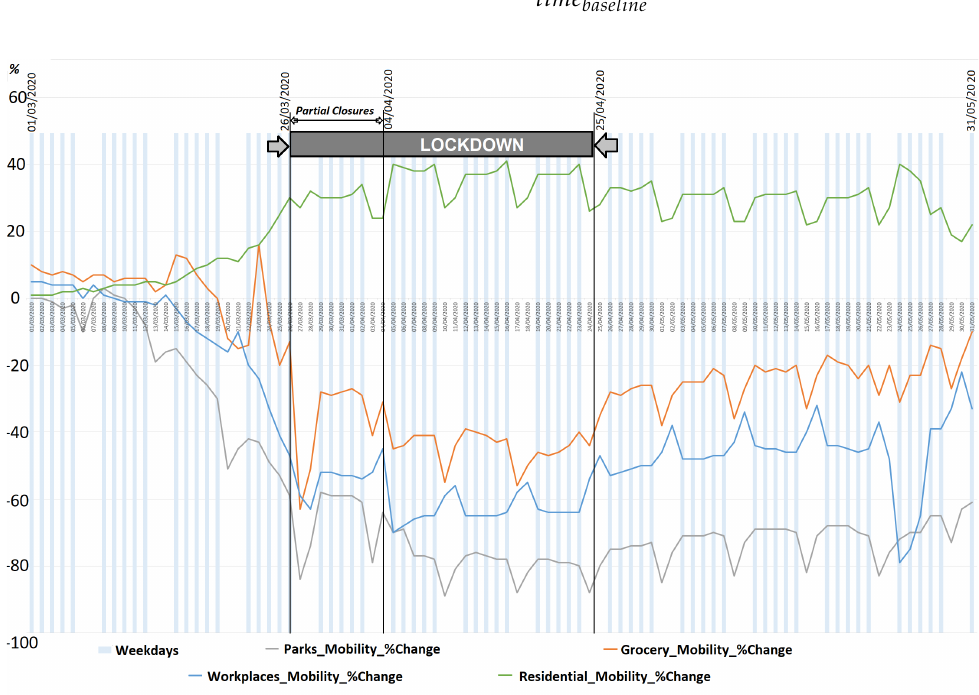
Figure 4. Google mobility chart for Dubai’s residents during the lockdown period